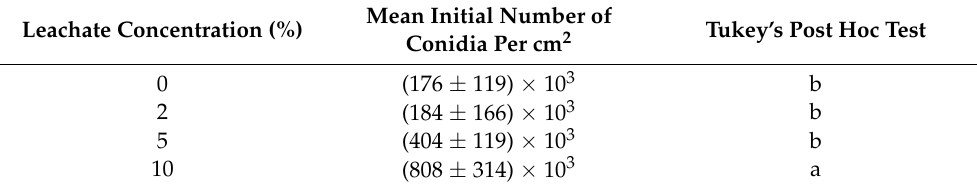
Table 1. Mean number of Fusarium oxysporum f. sp. radicis-lycopersici conidia produced per cm 2 of colony at different biosolid leachate–PDA concentrations in PDA. Different letters indicate statistically significant differences between the treatments according to Tukey’s post hoc test ( p < 0.05).